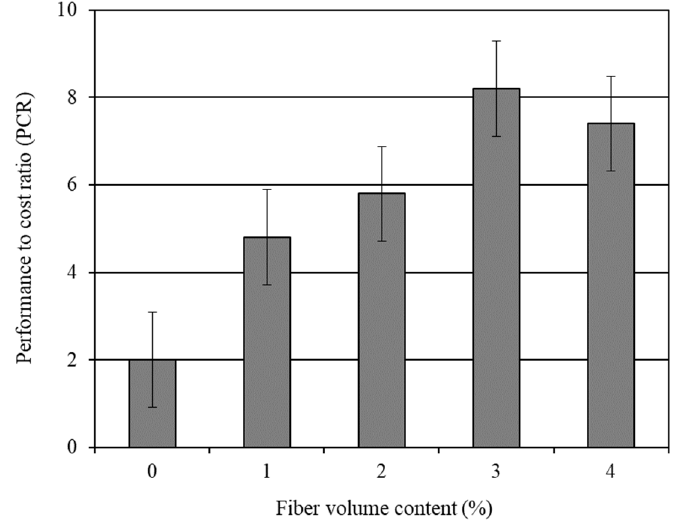
Figure 5. Influence of carbon fibers on the performance to cost ratio of mortar